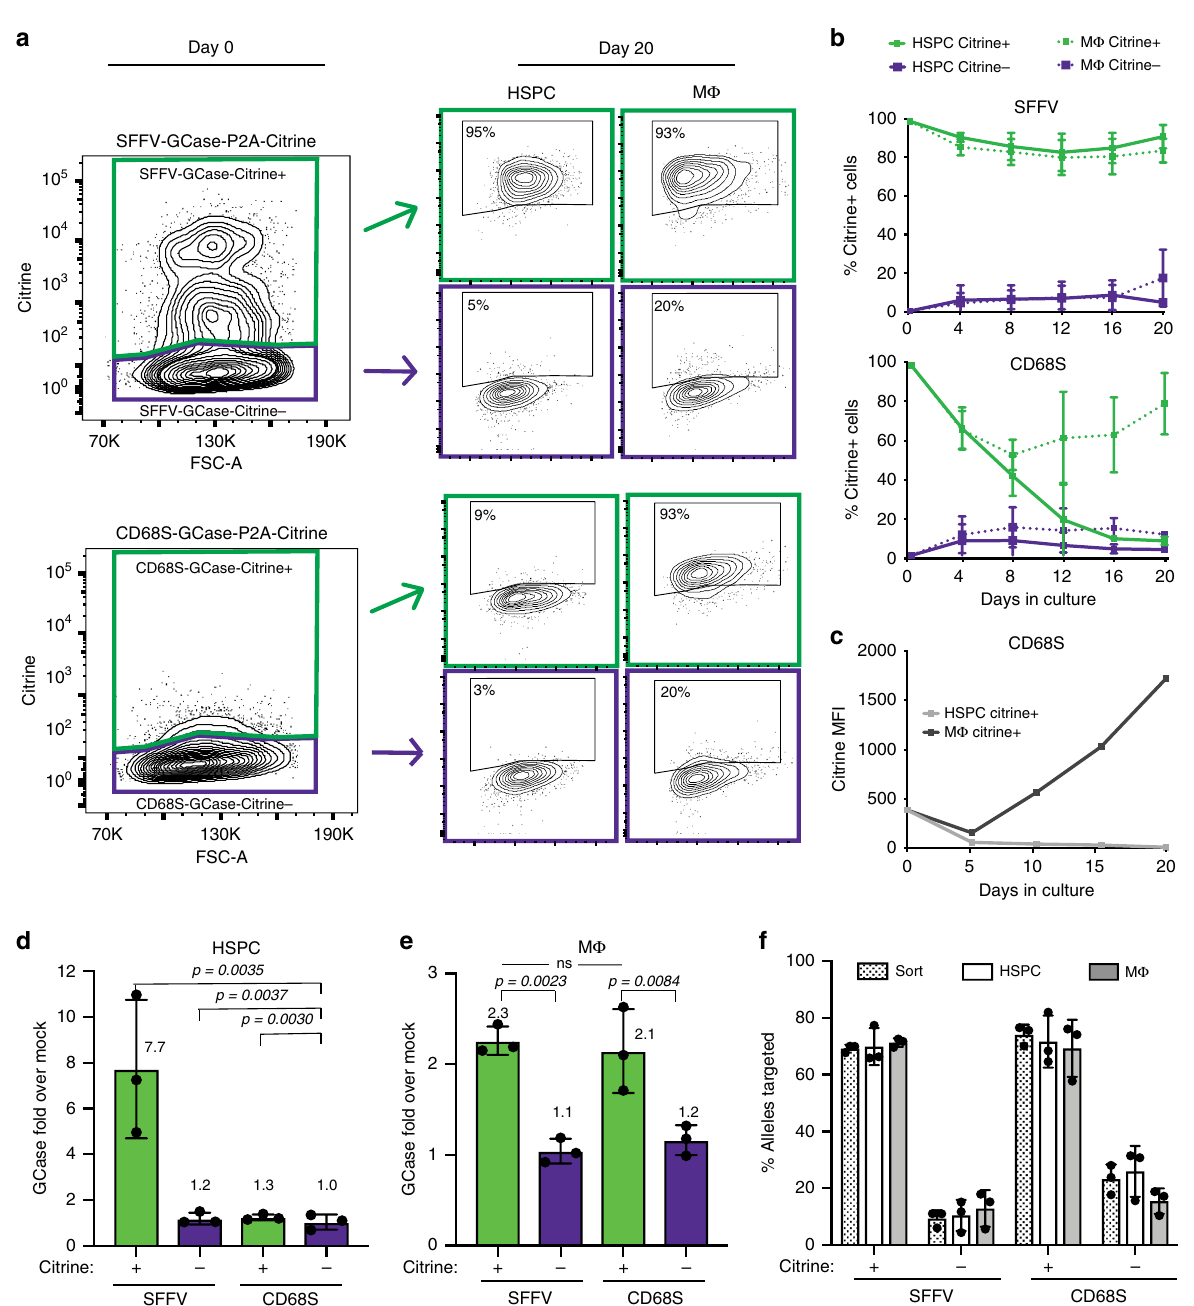
Fig. 3 CD68S promoter con fi nes GCase expression to the monocyte/macrophage lineage. a Representative fl ow plots showing Citrine + and Citrine – populations at the time of sort (day 0, 48-h post-modi fi cation) and after 20 days in HSPC maintenance (HSPC) or macrophage differentiation (M Φ ) cultures. b Citrine expression expressed as %Citrine + cells over time in HSPC and M Φ cultures. HSPC Citrine + (solid green line), HSPC Citrine – (solid purple line), M Φ Citrine + (dotted green line), M Φ Citrine – (dotted purple line) ( n = 3 biologically independent samples). c Representative Citrine expression expressed MFI over time in HSPC (gray) and M Φ (black) cultures in the CD68S-GCase-P2A-Citrine-targeted cells. d Fold GCase activity in HSPC and e M Φ cultures in targeted cells compared to unmodi fi ed (mock-treated) cells ( n = 3 biologically independent samples). Comparisons between groups were performed using one-way ANOVA test and post-hoc comparisons were made with the Tukey ’ s multiple comparisons test. f Percent of targeted CCR5 alleles at the time of sort (dotted) and after 20 days in HSPC (white) and M Φ (gray) cultures ( n = 3 biologically independent samples). Data shown as mean ± SD. Source data are provided as a Source Data fi 17.7% (min: 5.1%; max: 39.6%), 61.7% (min: 22.1%; max: 85.8%), NSG mice expressing human interleukin-3 (IL-3), human and 33.6% (min: 1.8%; max: 72%) in the bone marrow, spleen and granulocyte/macrophage-stimulating factor (GM-CSF), and peripheral blood, respectively (Fig. 6a). The median allele human Stem Cell Factor (SCF or KIT-ligand), cytokines that targeting frequencies of the engrafted cell populations were support the engraftment and differentiation of human-myeloid 15.6% (min: 12%; max: 20%), 20.4% (min: 16%; max: 25%), 5.0% lineages 36,37 . At 16 weeks, transplantation of CD68S-GCase-P2A- (min: 2%; max: 29%) in the same tissues (Fig. 6b). The observed Citrine-targeted cells resulted in median human cell chimerism of